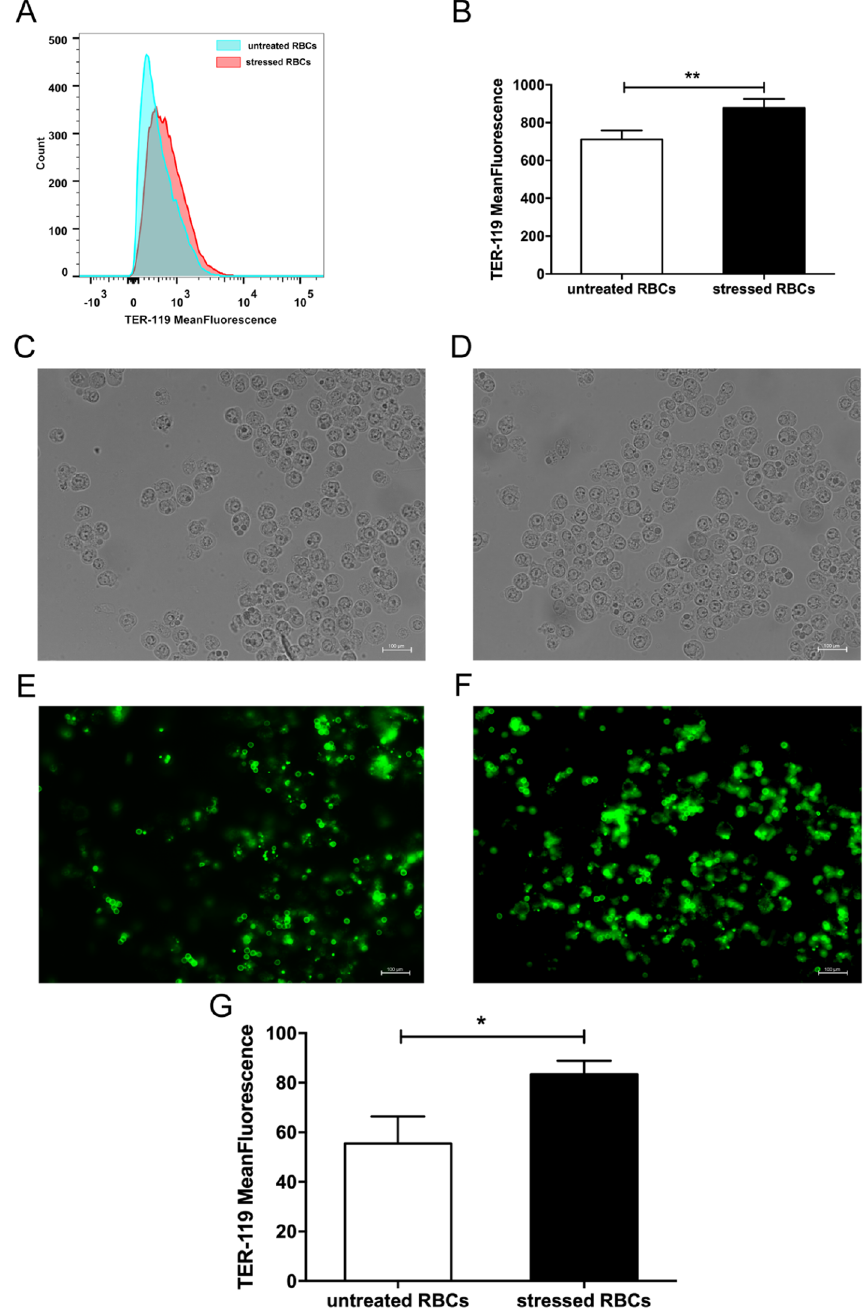
Figure 2. Stressed RBCs tended to be phagocytosed. FITC-TER 119-labelled RBCs were incubated with BALB/c macrophage cell line Raw 264.7 (n = 9). ( A , B ) FACS results of erythrophagocytosis. Erythrophagocytosis was represented by FITC-mean fluorescence intensity. ( C , F ) Immunofluorescence results of erythrophagocytosis. Bright field showed macrophages treated with untreated RBCs ( C ) and stressed RBCs ( D ), fluorescence field showed TER-119 labelled untreated RBCs ( E ) and stressed RBCs ( F ). Arrow showed RBCs located in macrophages. ( G ) statistic results of erythrophagocytosis of untreated RBCs and stressed RBCs (* p < 0.05; ** p <